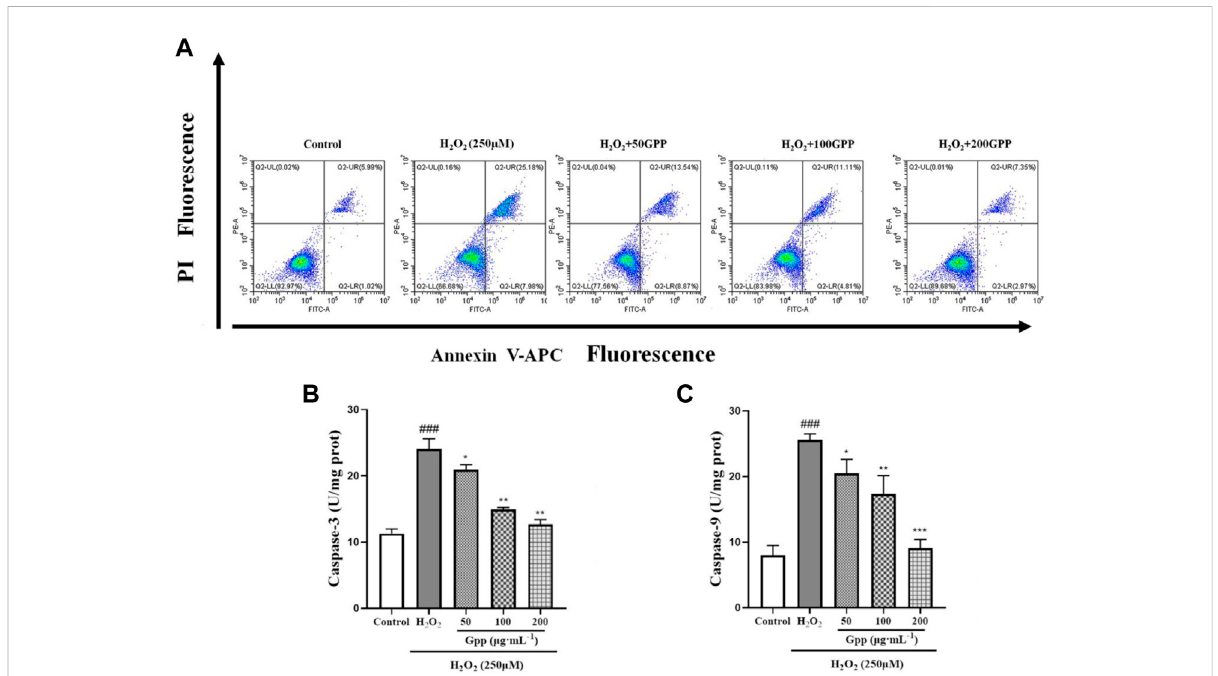
Quantitativeanalysisof GPP pretreatment on apoptosis in injury models, where (A) is therate ofapoptosis detected using fl ow cytometry, (B) is theresult of Caspase-3 proteincontent measurement, and (C) istheresult ofCaspase-9 proteincontentmeasurement.* p < 0.05, ** p < 0.01, *** p <